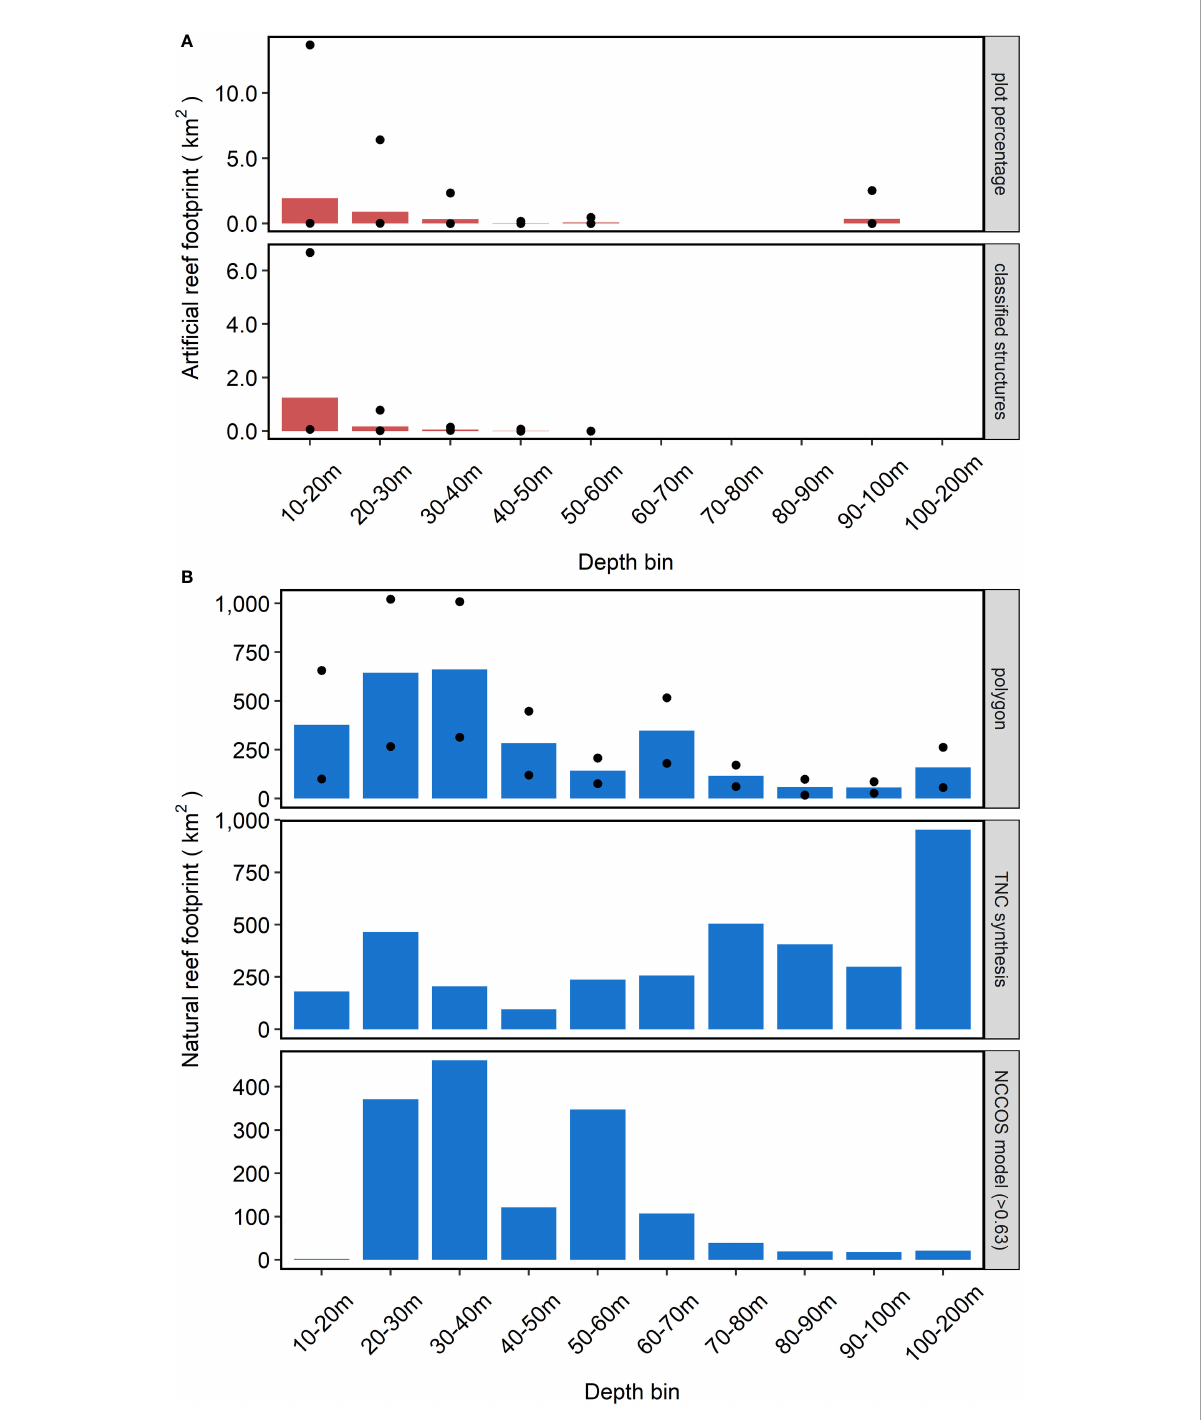
FIGURE 5 Extent of arti fi cial reefs (A) and natural reefs (B) by depth bin. Measured approach for arti fi cial reef footprint not shown because only applied to NC. Twelve arti fi cial reefs did not have assigned values, so these arti fi cial reefs permitted plots and structures are not represented in this fi gure. Black circles represent the maximum and minimum extent values for applicable methods. Note different y-axis scales between panels (A, B)